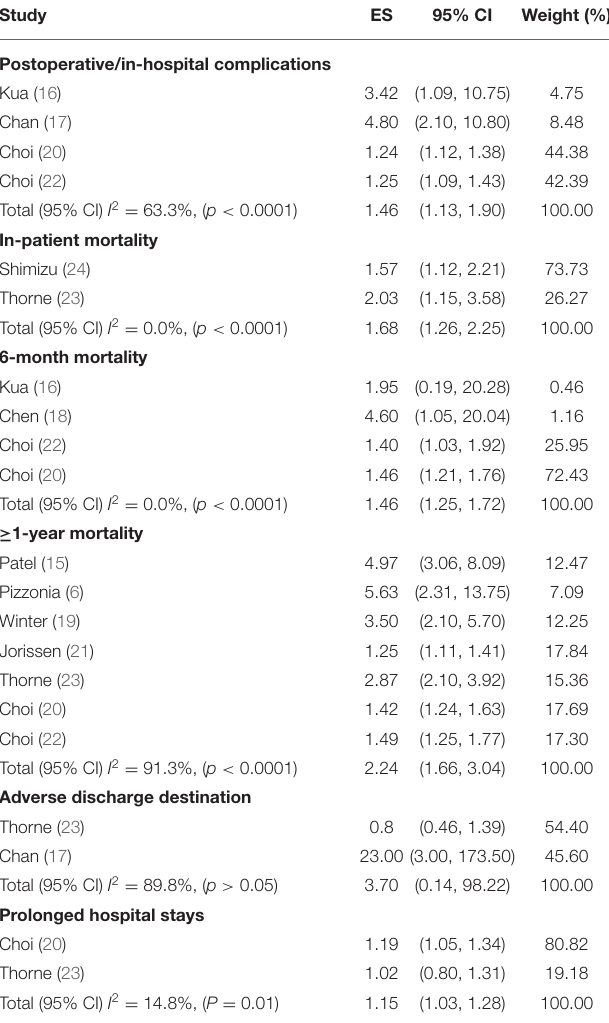
TABLE 2 | Results of